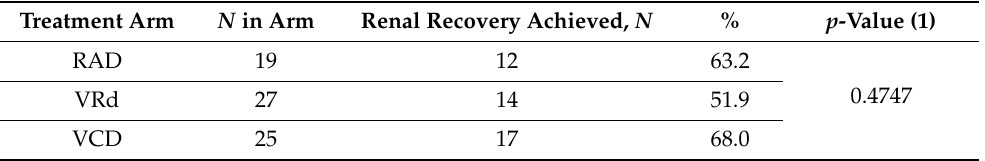
Table 3. Renal recovery—estimated glomerular filtration rate (according to Dimopoulos et al., 2010). Population: per-protocol set, patients with eGFR < 50 mL/min at baseline, N = 71. Treatment Arm N in Arm